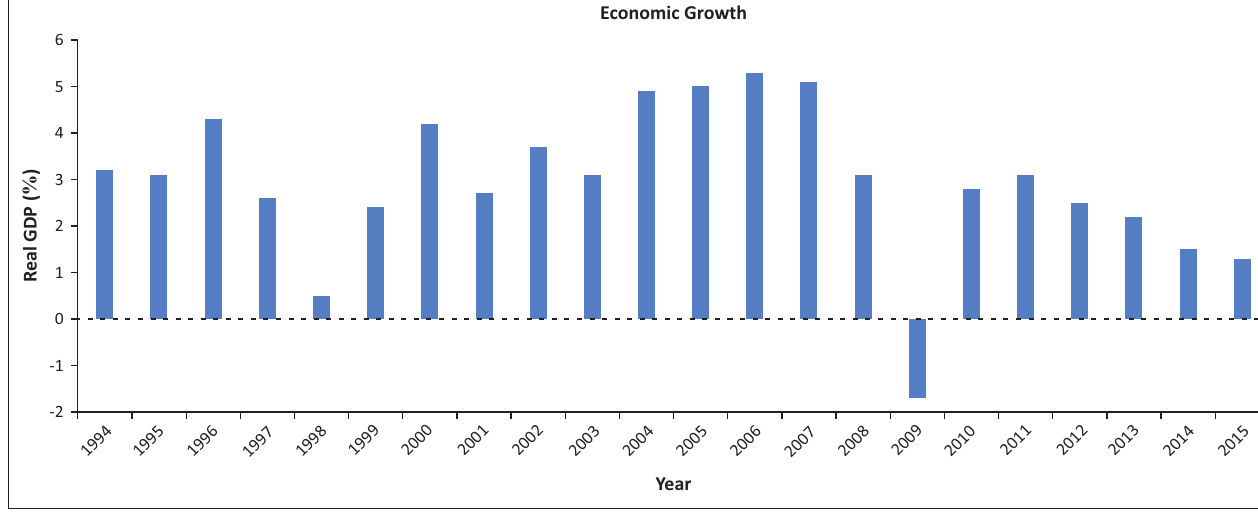
FIGURE 1: Economic growth in South Africa: 1994–2015.